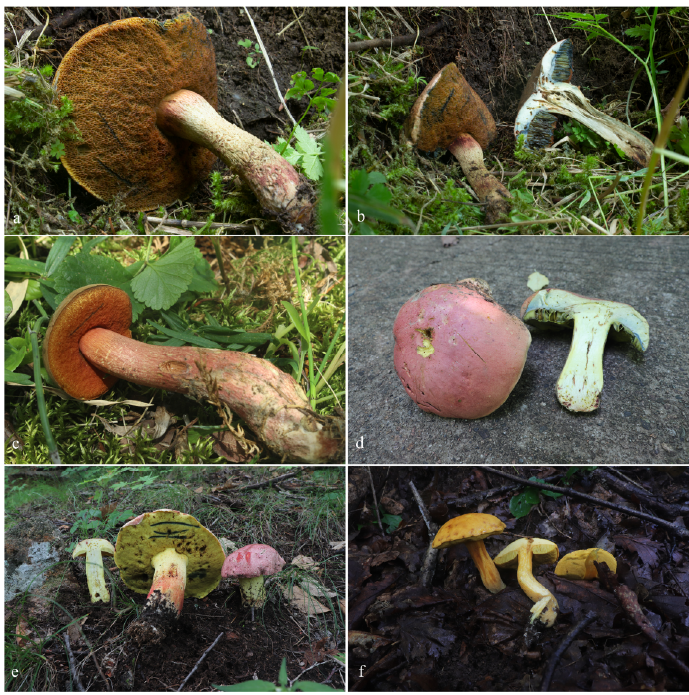
Figure 5. Basidiomata of boletes. ( a – c ) Suillellus lacrymibasidiatus ; ( d ) Butyriboletus subregius ; ( e ) Butyriboletus pseudoroseoflavus (e from HMJAU 59470); ( f ) Tengioboletus subglutinosus (f from HMJAU 59037). ( a – c ) Photos by Yang Wang; ( d – f ) Photos by Yong-Lan Tuo. Etymology. The epithet “ pseudoroseoflavus ” refers to its similarity to B. roseoflavus . Holotypus. China. Jilin Province, Jian city, Wunvfeng National Forest Park, 125 ◦ 34 (cid:48) 33 (cid:48)(cid:48)